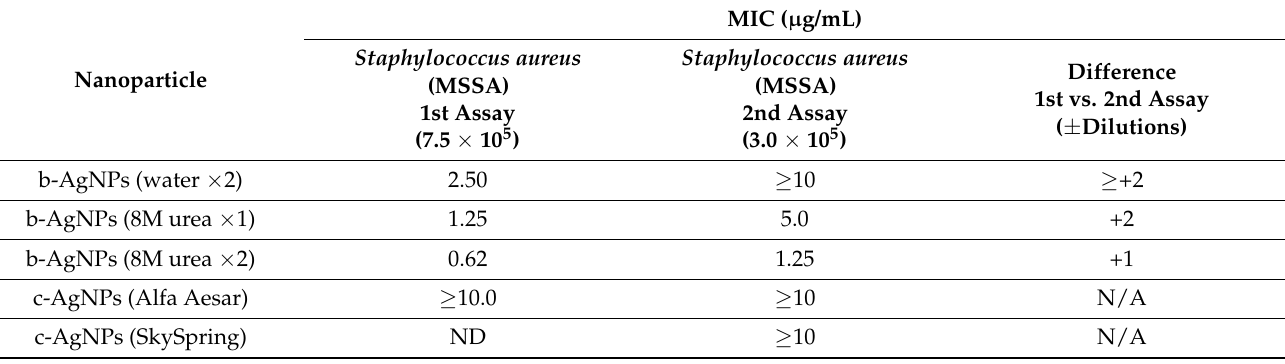
Table 6. Minimum inhibitory concentrations (MIC) of tested nanoparticles against Staphylococcus aureus (MSSA) one year